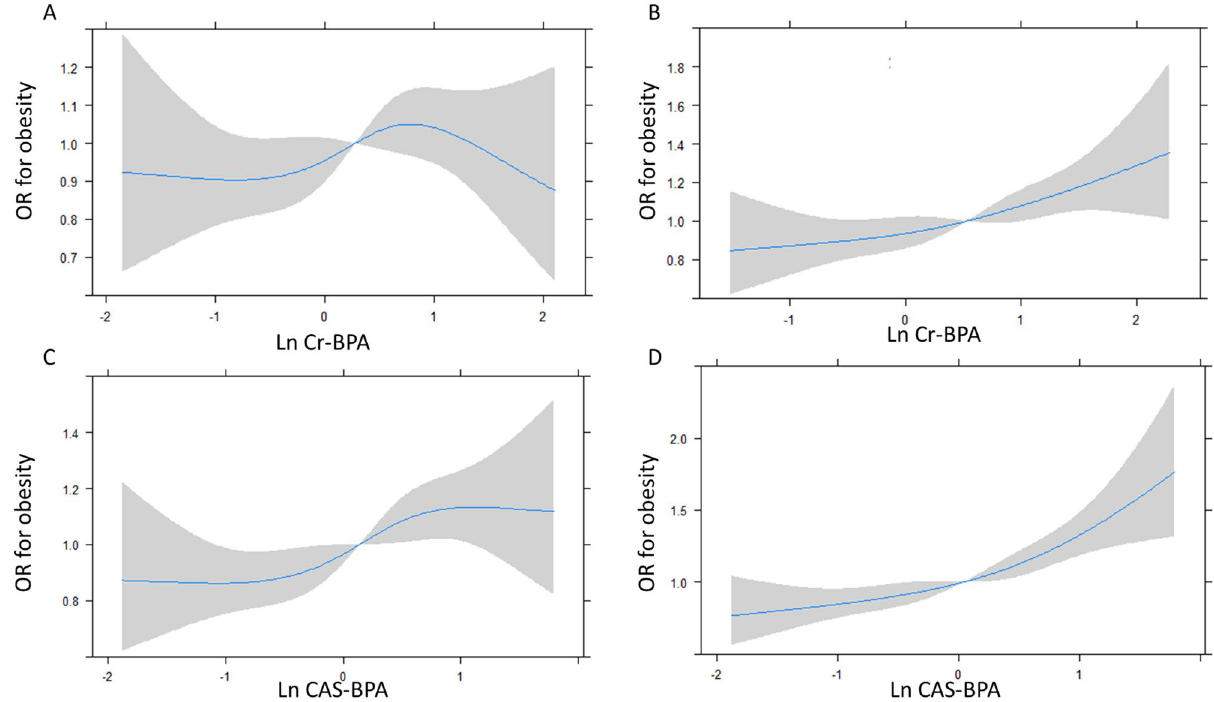
Figure 2. Shape of sex-specific associations between natural log-transformed bisphenol A and obesity risk, which was analyzed using a 4-knot restricted cubic spline plot model with conventional creatinine adjustment (Ln Cr-BPA) [(A) Males, (B) Females] and covariate-adjusted standardization method (Ln CAS- BPA) [(C) Males, (D) Females]. Values were adjusted for age, sex, household income, smoking, alcohol consumption, and physical